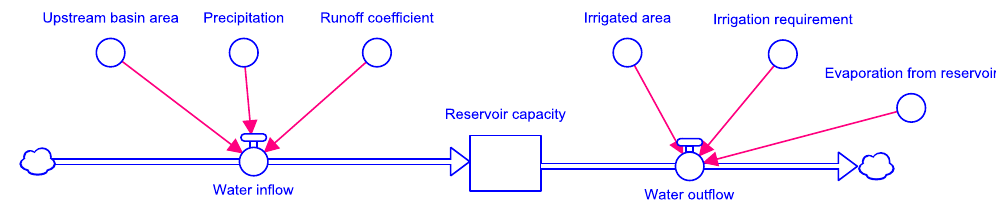
Figure 1. Scheme of the system structure used to estimate the reservoir water balance.